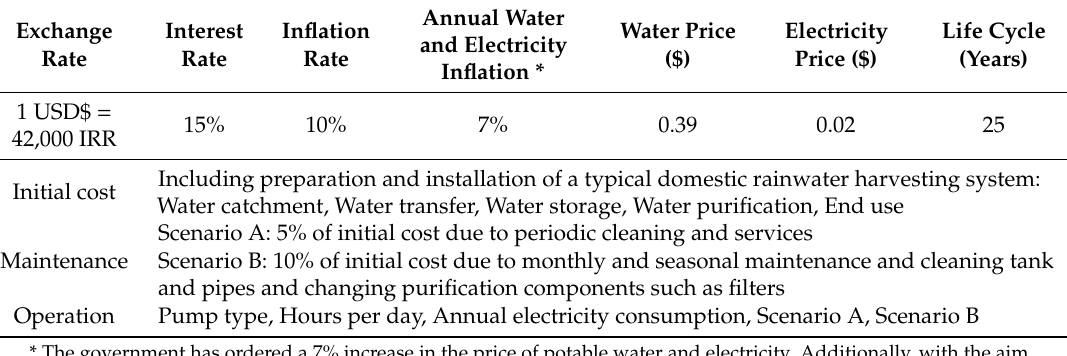
Table 2. Determinant values in economic analysis in this